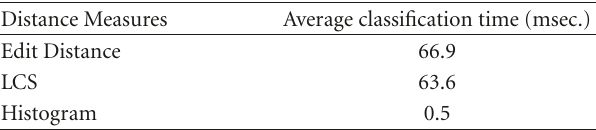
Table 4: The classification times of the nearest-neighbour rule.